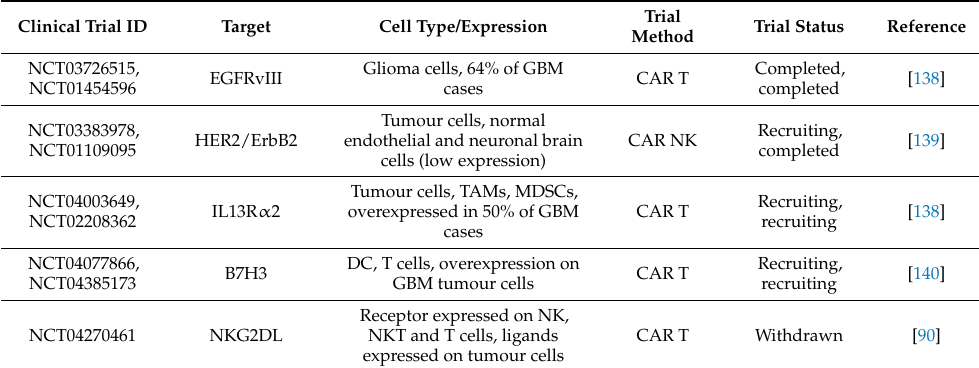
Table 2. Current targets used in CAR T and NK cell therapy for